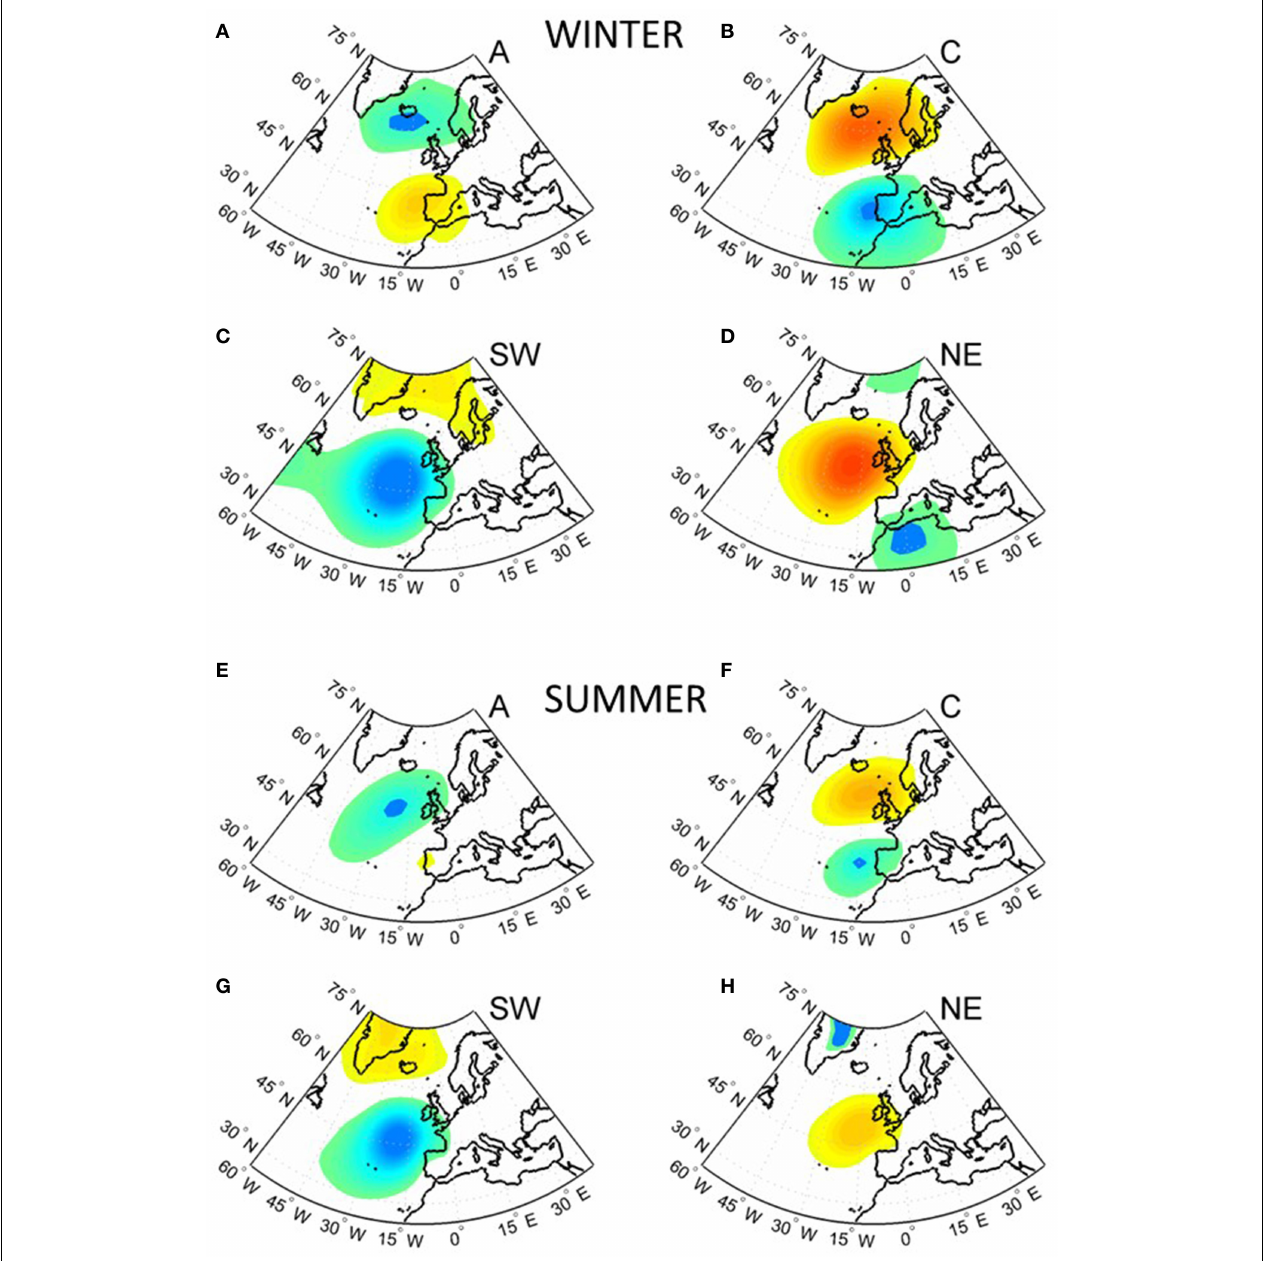
FIGURE 4 | Anomaly composites of pressure (colorbar; mb) at sea level (SLP) in days classified as A, C, SW, and NE. The anomaly fields are shown for winter (A–D) and summer (E–H) .